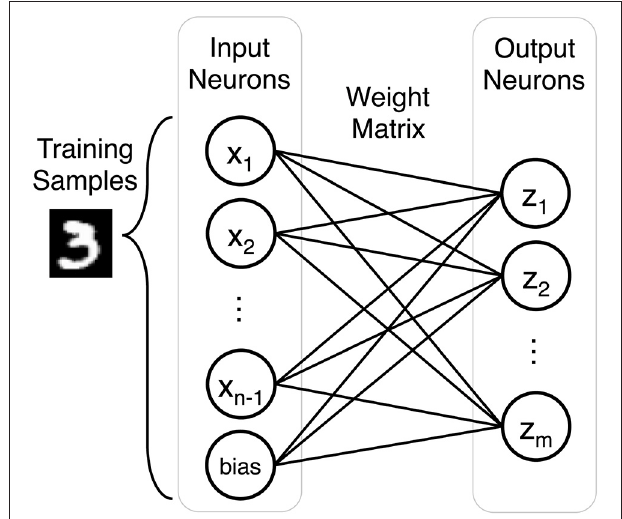
FIGURE 1 | Each training sample is represented by n input neurons ( n -1 input neurons and a bias term). The weight matrix is an m by n array composed of the weights that connect input neurons to output neurons in the single layer